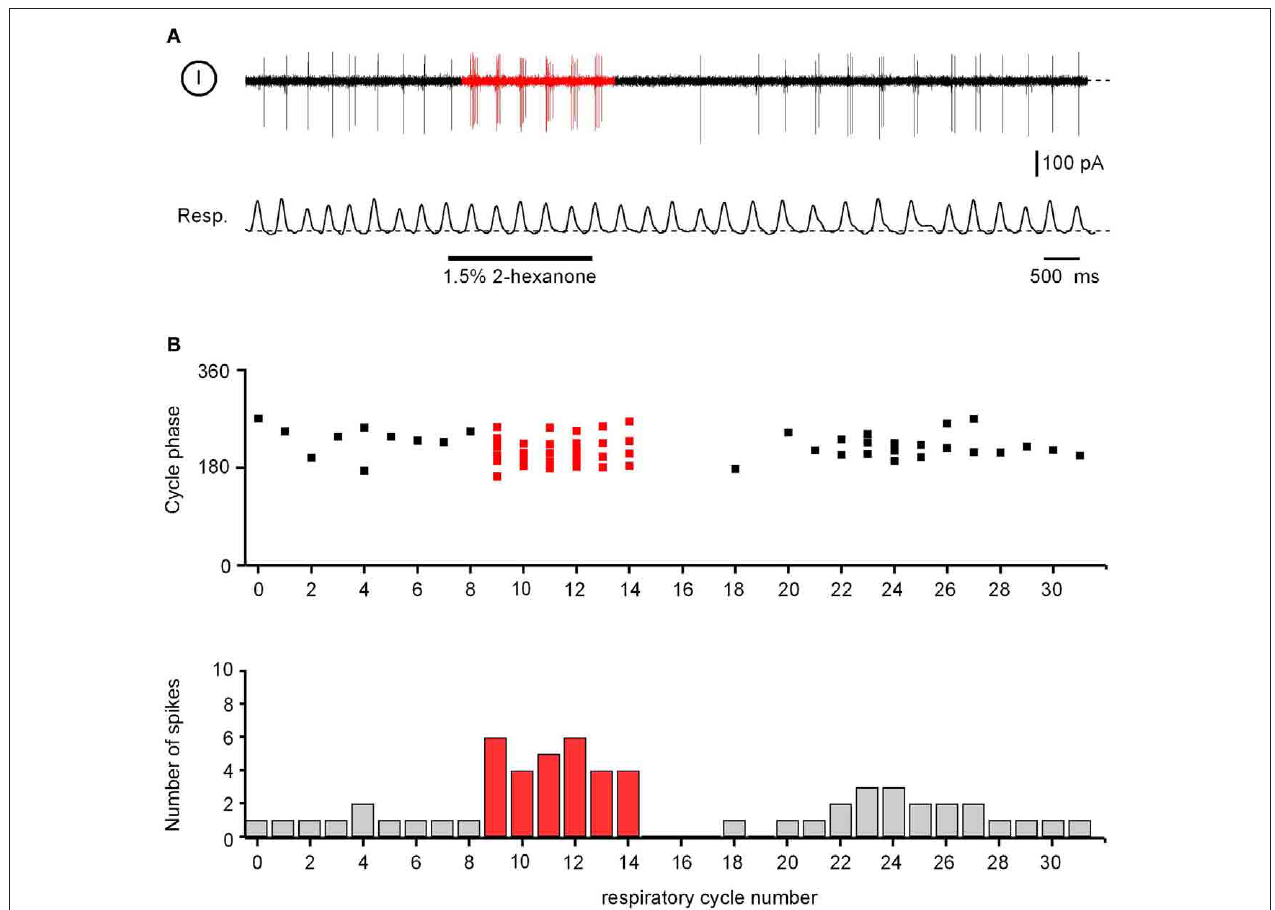
FIGURE A3 | Spontaneousandodor-evokedactivityinONjuxtaglomerular neurons.(A) Action potential firing of ajuxtaglomerular neuron (top) recorded simultaneously withthe respiration ofthe mouse (bottom). (B) Top: distribution